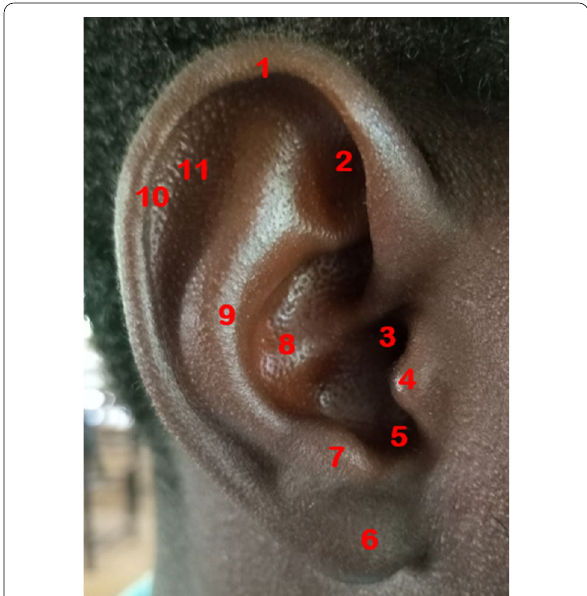
Fig. 1 shows anatomical structure of the human external ear: (1) helix, (2) fossa, (3) external auditory canal, (4) tragus, (5) incisura, (6) lobule, (7) antitragus, (8) concha, (9) antihelix, (10) Darwin’s tubercle, (11)